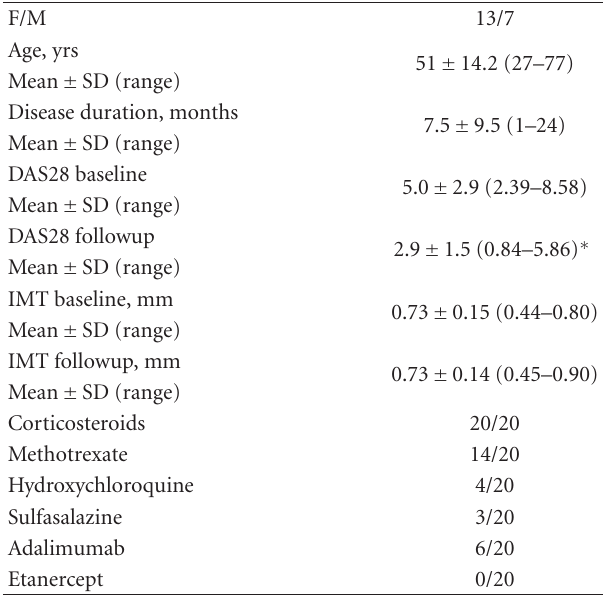
Table 1: Demographic and clinical characteristic of ERA